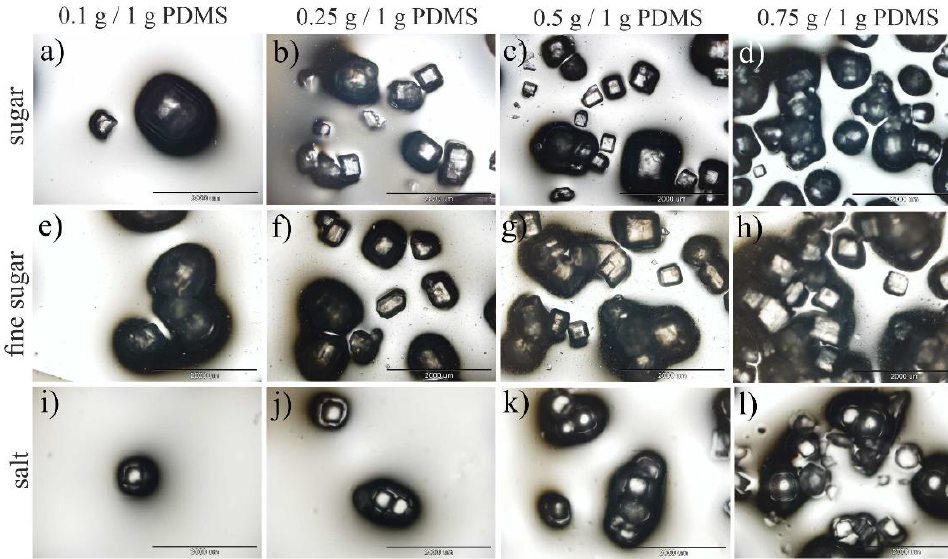
Figure 4. Three-dimensional PDMS structures prepared by ( a – d ) adding sugar, ( e – h ) fine sugar, and ( i – l ) salt to the PDMS mixture. The scale bar corresponds to 2000 μ m.